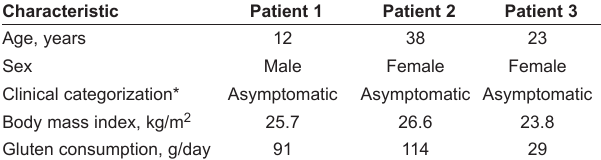
Table 3 Demographic and some clinical characteristics of the three patients with serological diagnosis of celiac